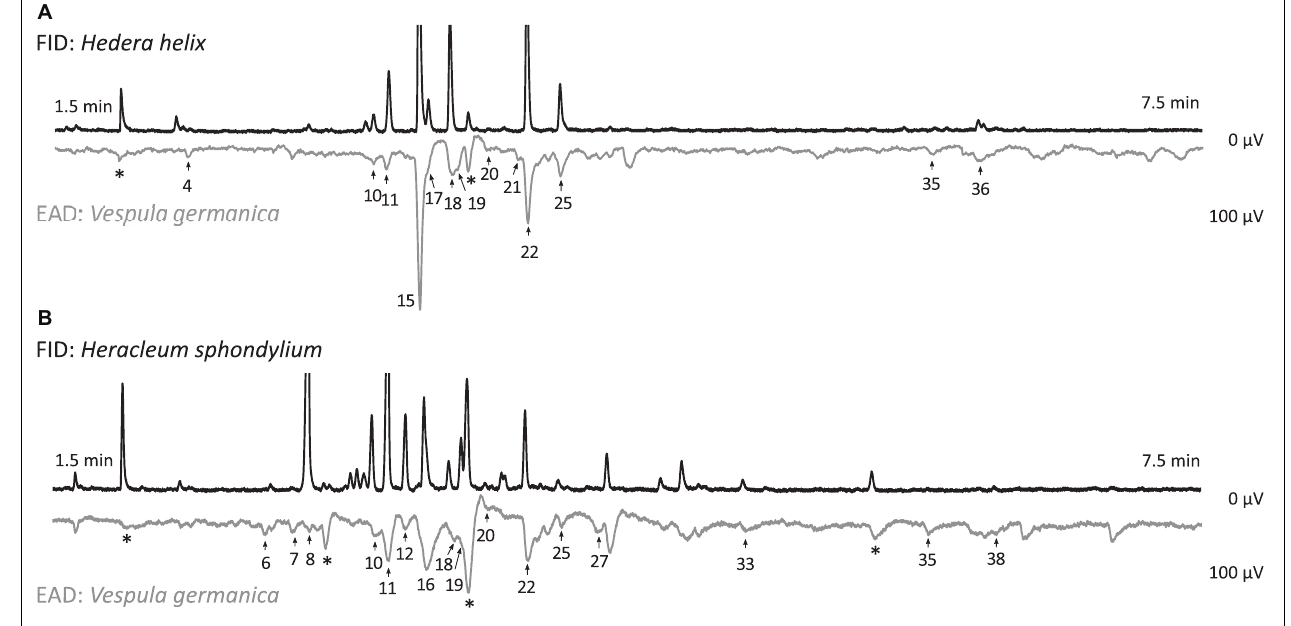
FIGURE 2 | Electroantennographic responses of Vespula vulgaris antennae (EAD: electroantennographic detection) to floral scent samples (FID: flame ionization detection) of (A) Hedera helix and (B) Heracleum sphondylium . Numbers of EAD responses correspond to numbers given in Table 1 (*, responses to contamination). Axes show retention time and amplitude of